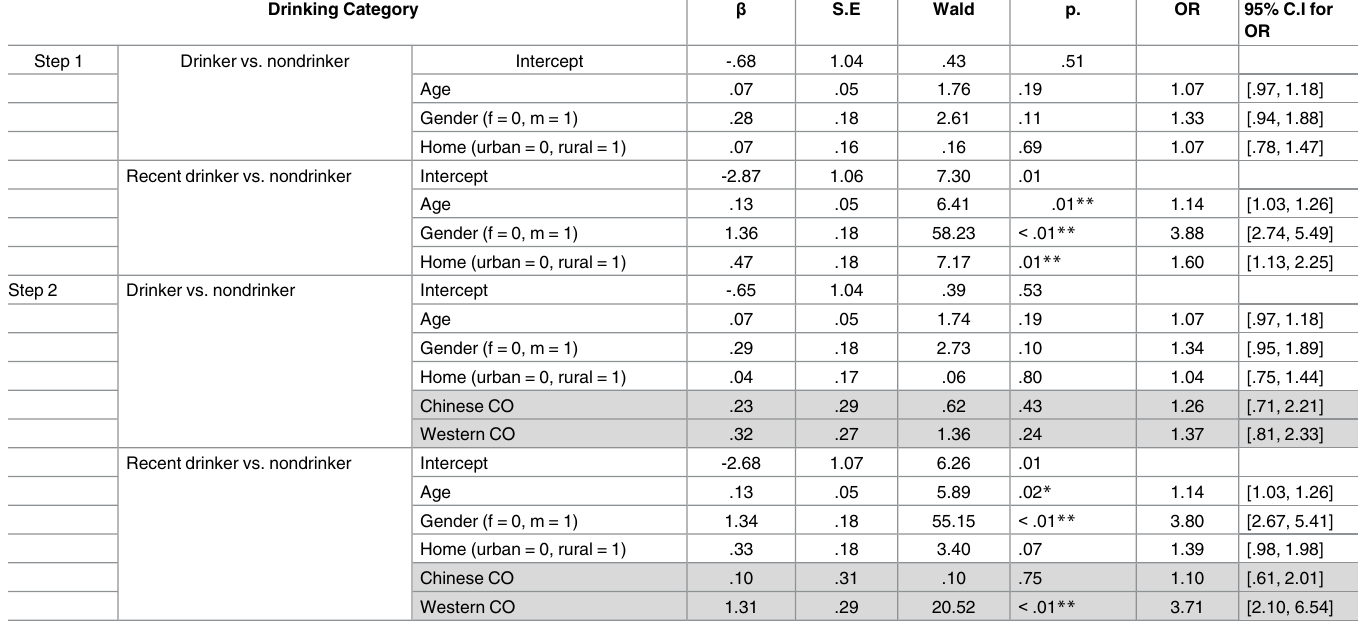
Table 2. Hierarchical logistic